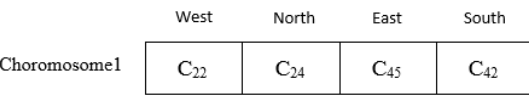
Figure 2. Format of encoded chromosome.